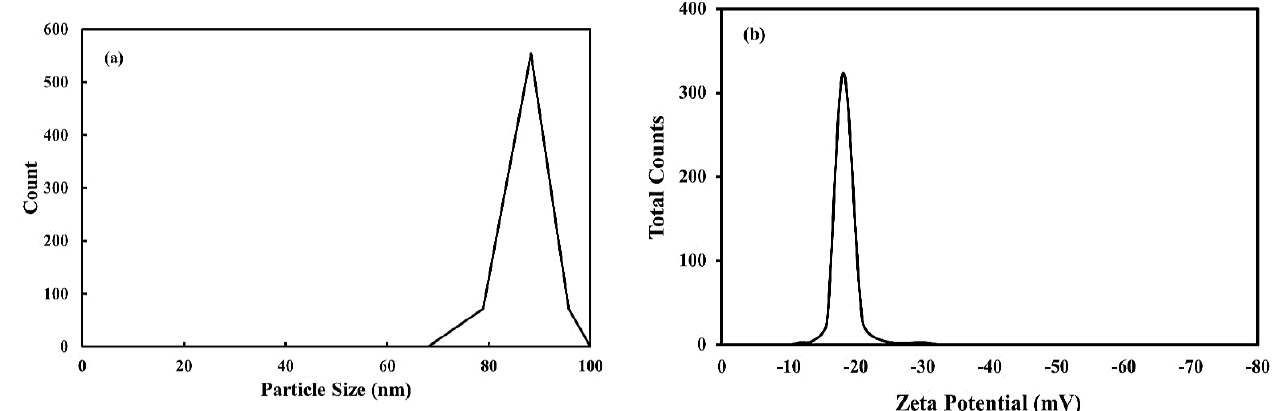
Figure 3. ( a ) DLS measurements of particle size distribution and ( b ) charge zeta potential of Co 3 O 4 NPs synthesized using rosemary leaf extract.